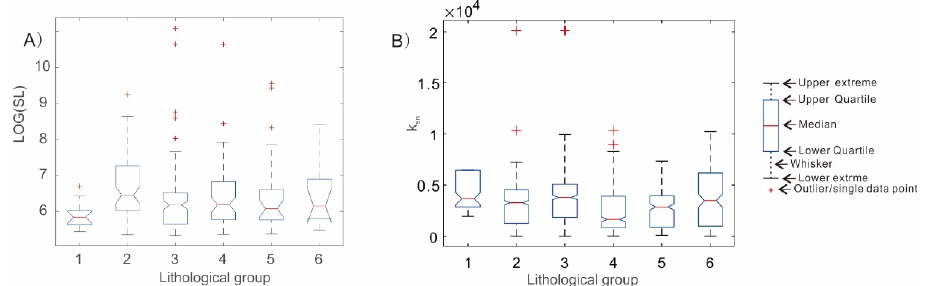
Figure 10. ( A ) Statistical correlation between SL values and their underlying lithological groups. ( B ) Statistical correlation between K sn values and their underlying lithological groups. Lithology groups: 1. Quaternary unconsolidated sediments, 2. Limestone, 3. Sandstone, 4. Metamorphic rock, 5. Volcanic rock, and 6. Granite (See Table 1 for details of the classification of each lithological group).